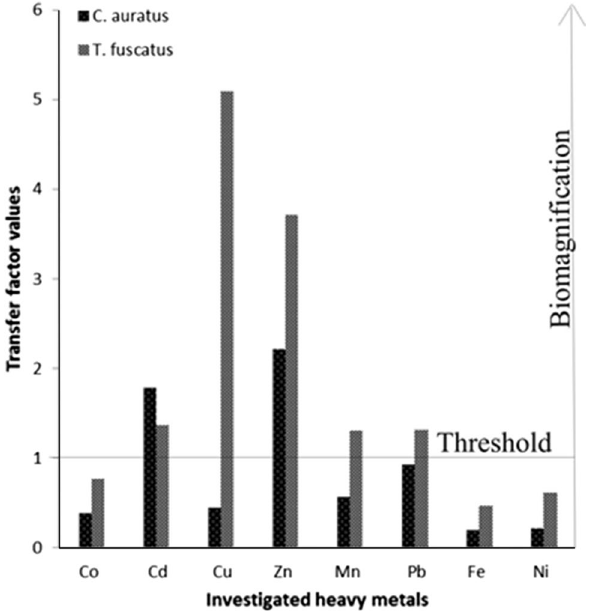
Fig. 7 Transfer factor of heavy metals in benthic fauna